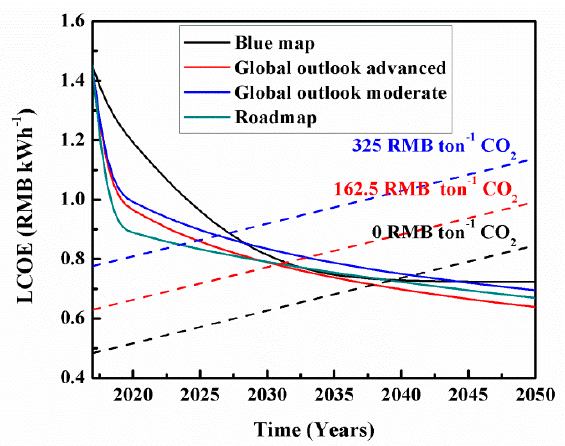
Figure 8. Future evolution of the LCOE for tower CSP systems and grid parities at four scenarios (solid line: tower CSP plants; dash line: coal-fired power plants).